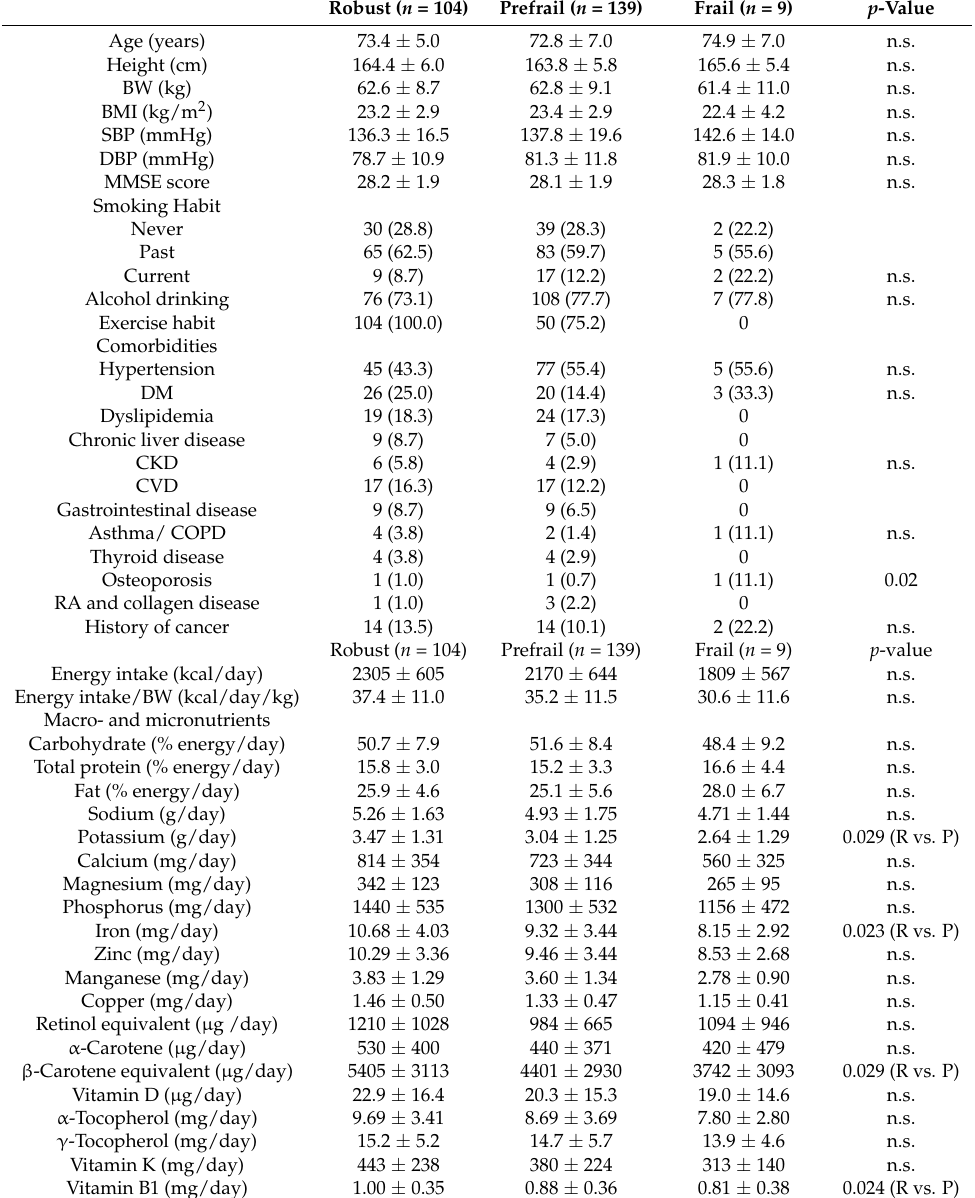
Table 4. Basic characteristics and dietary habits among frail, prefrail, and robust men, as diagnosed by the J-CHS